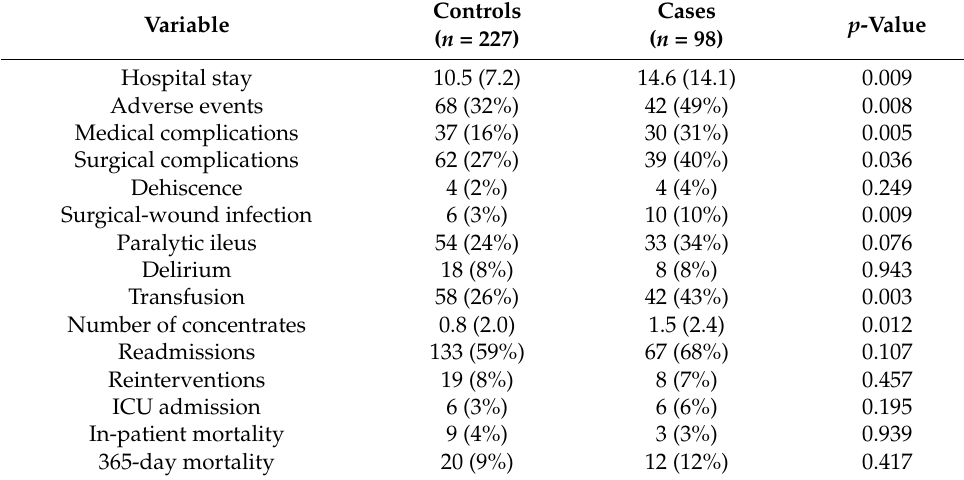
Table 2. Results during hospital admission.